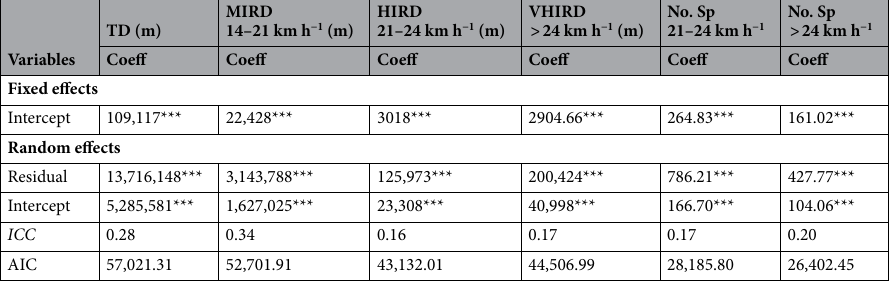
Table 1. Unconditional model results of match movement profiles for Spanish soccer teams. m meters, No. number, TD total distance, MIRD medium-intensity running distance, HIRD high-intensity running distance, VHIRD very high-intensity running distance, Sp21-24 Sprints between 21 and 24 km h −1 , Sp > 24 Sprints at speeds above 24 km h −1 , Coeff coefficient, ICC Intraclass Correlation Coefficient, AIC Akaike Information